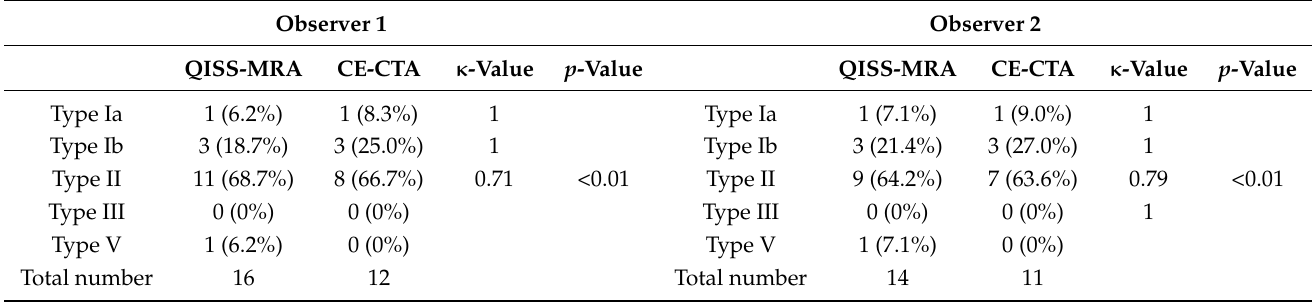
Table 2. Observer-specific intermodal